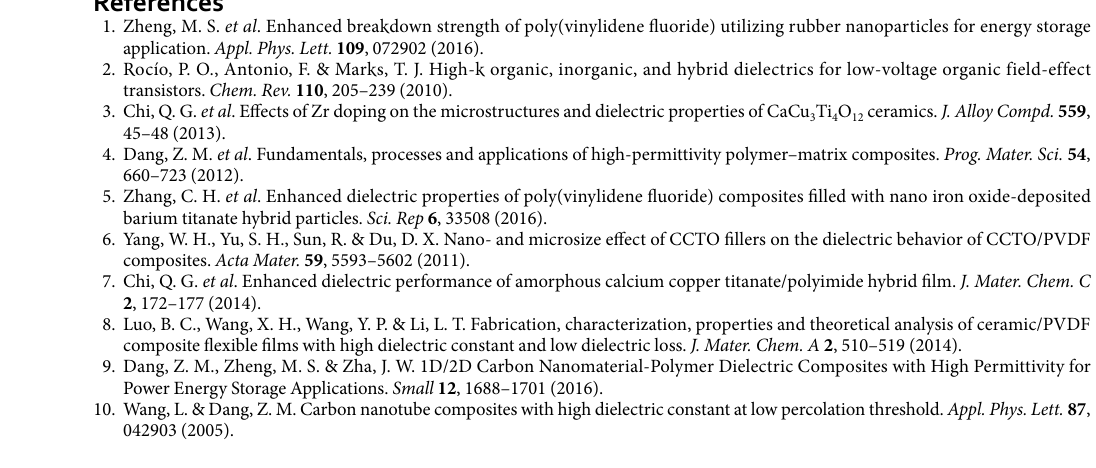
9 Scientific RepoRts | 7: 3072 | DOI:10.1038/s41598-017-03273-z